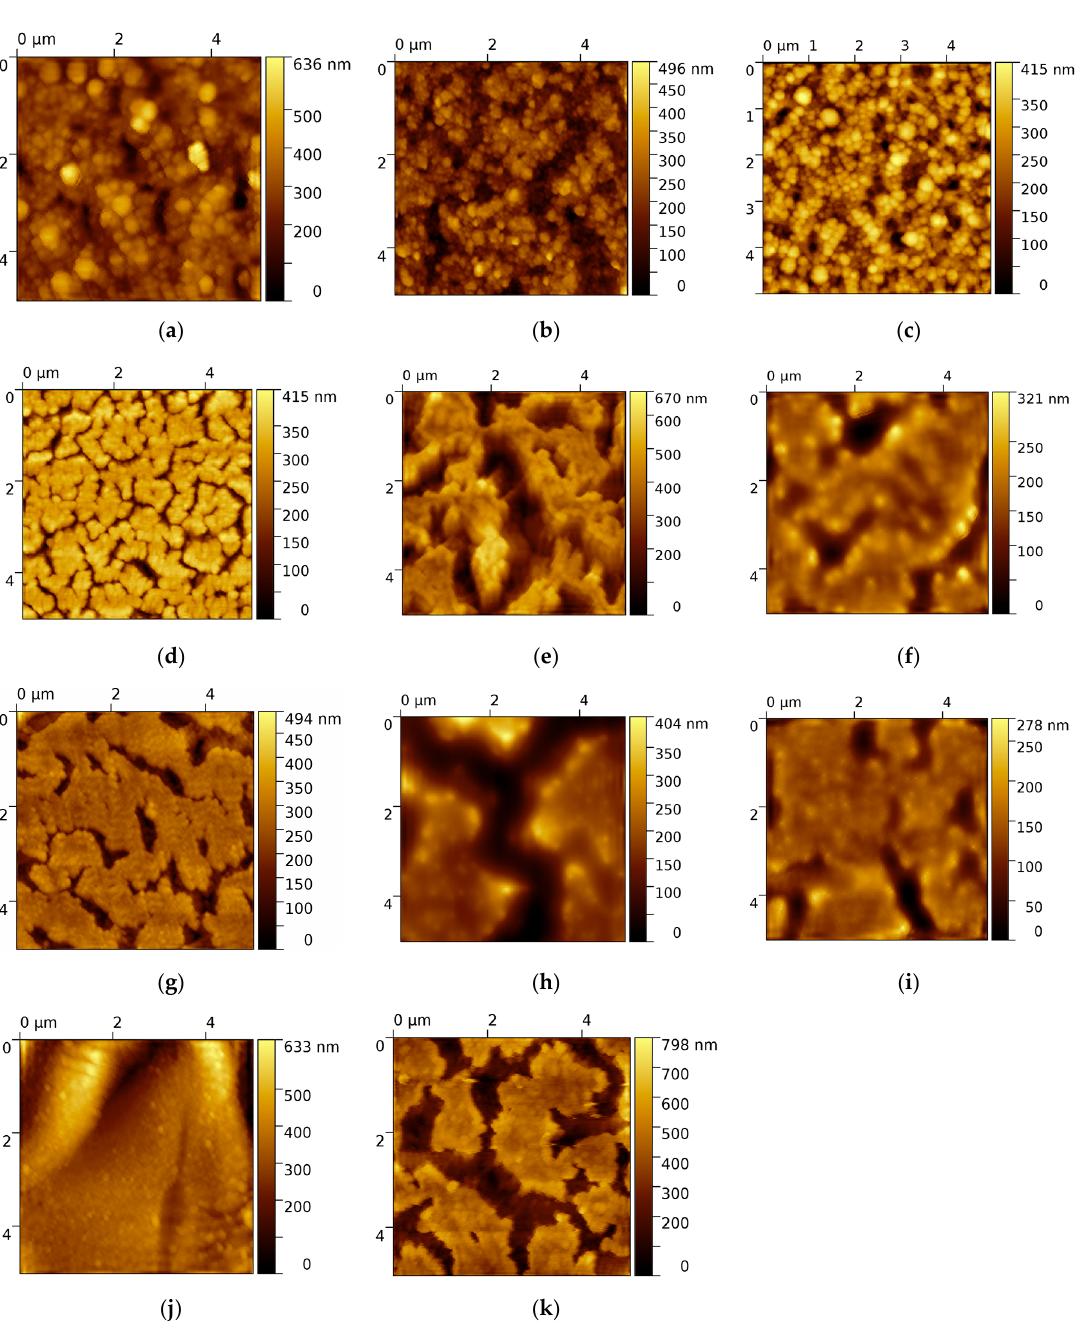
Figure 2. AFM surface, h 1 —PCPX thickness, h 2 —Ag thickness: ( a ) h 1 —300 nm, h 2 —10 nm; ( b ) h 1 —300 nm, h 2 —20 nm; ( c ) h 1 —300 nm, h 2 —30 nm; ( d ) h 1 —600 nm, h 2 —30 nm; ( e ) h 1 —900 nm, h 2 —30 nm; ( f ) h 1 —900 nm, h 2 —50 nm; ( g ) h 1 —900 nm, h 2 —65 nm; ( h ) h 1 —1500 nm, h 2 —20 nm; ( i ) h 1 —1500 nm, h 2 —30 nm; ( j ) h 1 —2000 nm, h 2 —30 nm; ( k ) h 1 —300 nm, h 2 —30 nm, T = 300 ° С .